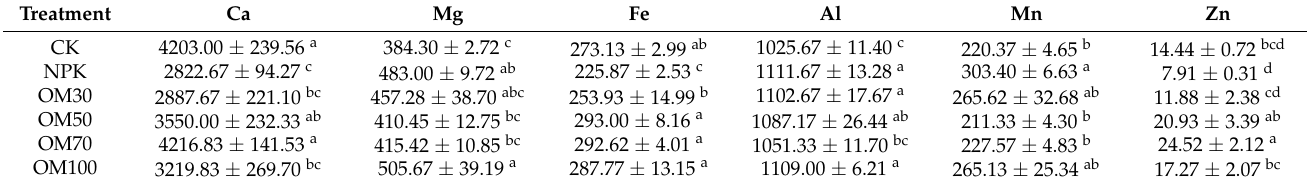
Table 5. The exchangeable nutrients of soil treated with different fertilizers (mean ± standard error) (mg kg − 1 soil).